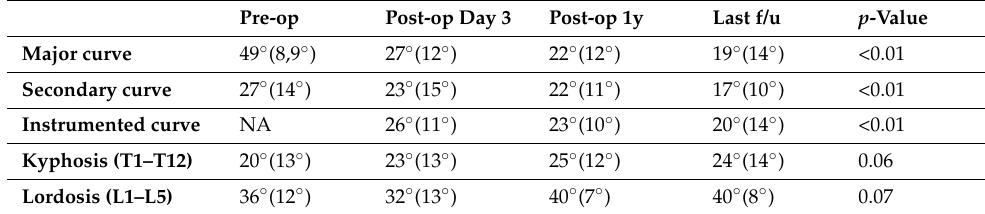
Table 2. Comparison of the coronal and sagittal radiological parameters between post-op day 3 and last follow-up (95% of the patients were Risser 3 or more at last f/u; 5% were still at Risser 2 with ongoing significant growth). The curvatures were measured using the Cobb method. The results are expressed as mean and standard deviations.